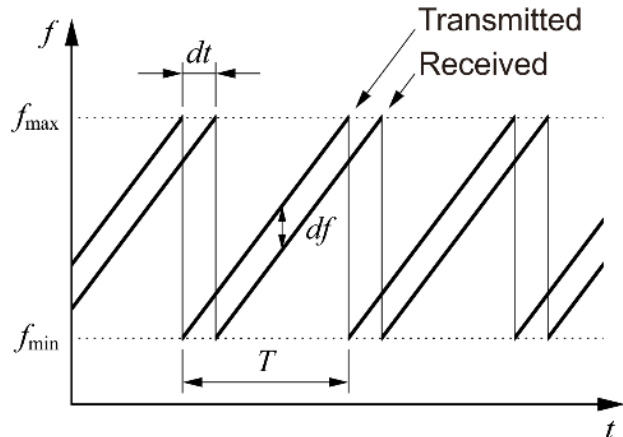
Figure 1. Principle of the FMCW radar. In this plot, the delay 𝑑𝑡 is exaggerated for the sake of clarity; in practice, the delay is usually smaller by several orders of magnitude than the period 𝑇 of the sawtooth profile. Similarly, the beat frequency 𝑑𝑓 is normally much smaller than the frequency span 𝑓 max − 𝑓 min .